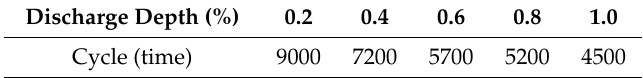
Table 1. Relationship between the charge/discharge depth and cycle life of Lithium-ion battery system.